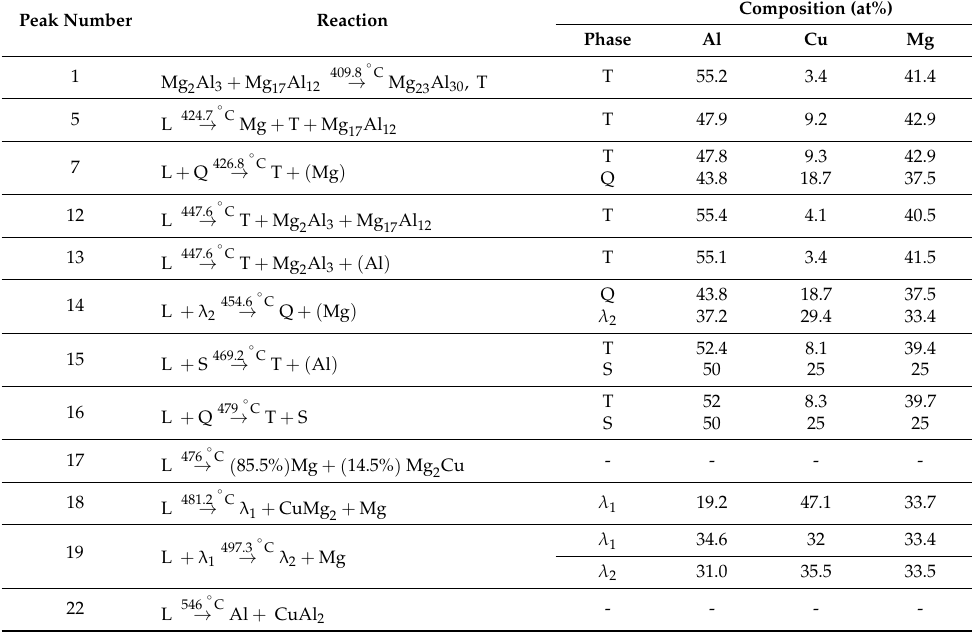
Figure 5. ( A ) Eutectic liquid formation within the Mg-side of the sample ( B ) Detailed view of the highlighted region showing eutectic liquid along the grain boundary. Table 2. Liquid forming reactions occurring at the interface and within the grain boundary of the Mg-side during the bonding process.